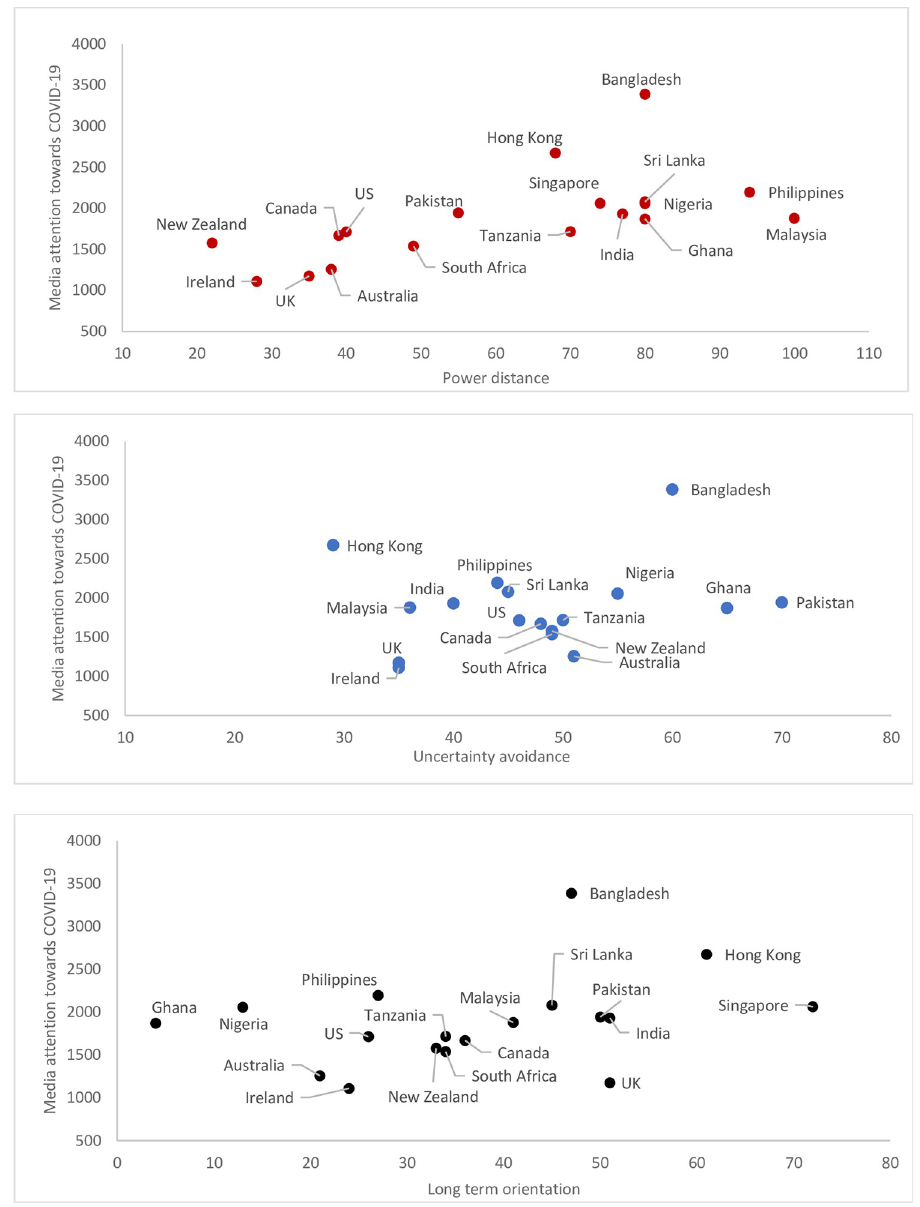
Fig 2. Scatterplots of power distance, uncertainty avoidance, and long-term-orientation against media attention towards COVID-19 for 18 countries.